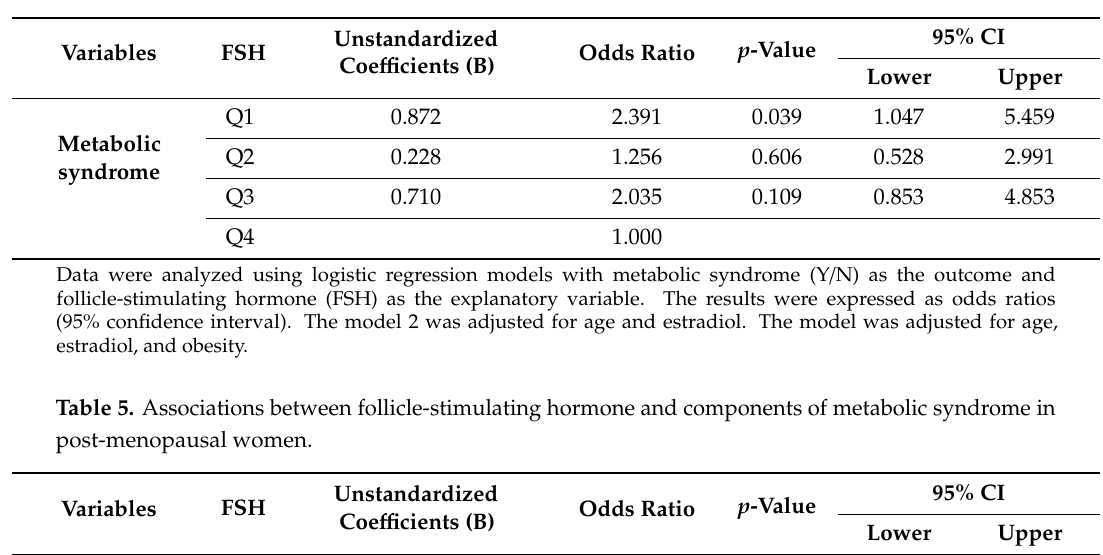
Table 4. Associations between follicle-stimulating hormone and metabolic syndrome in post-menopausal women.